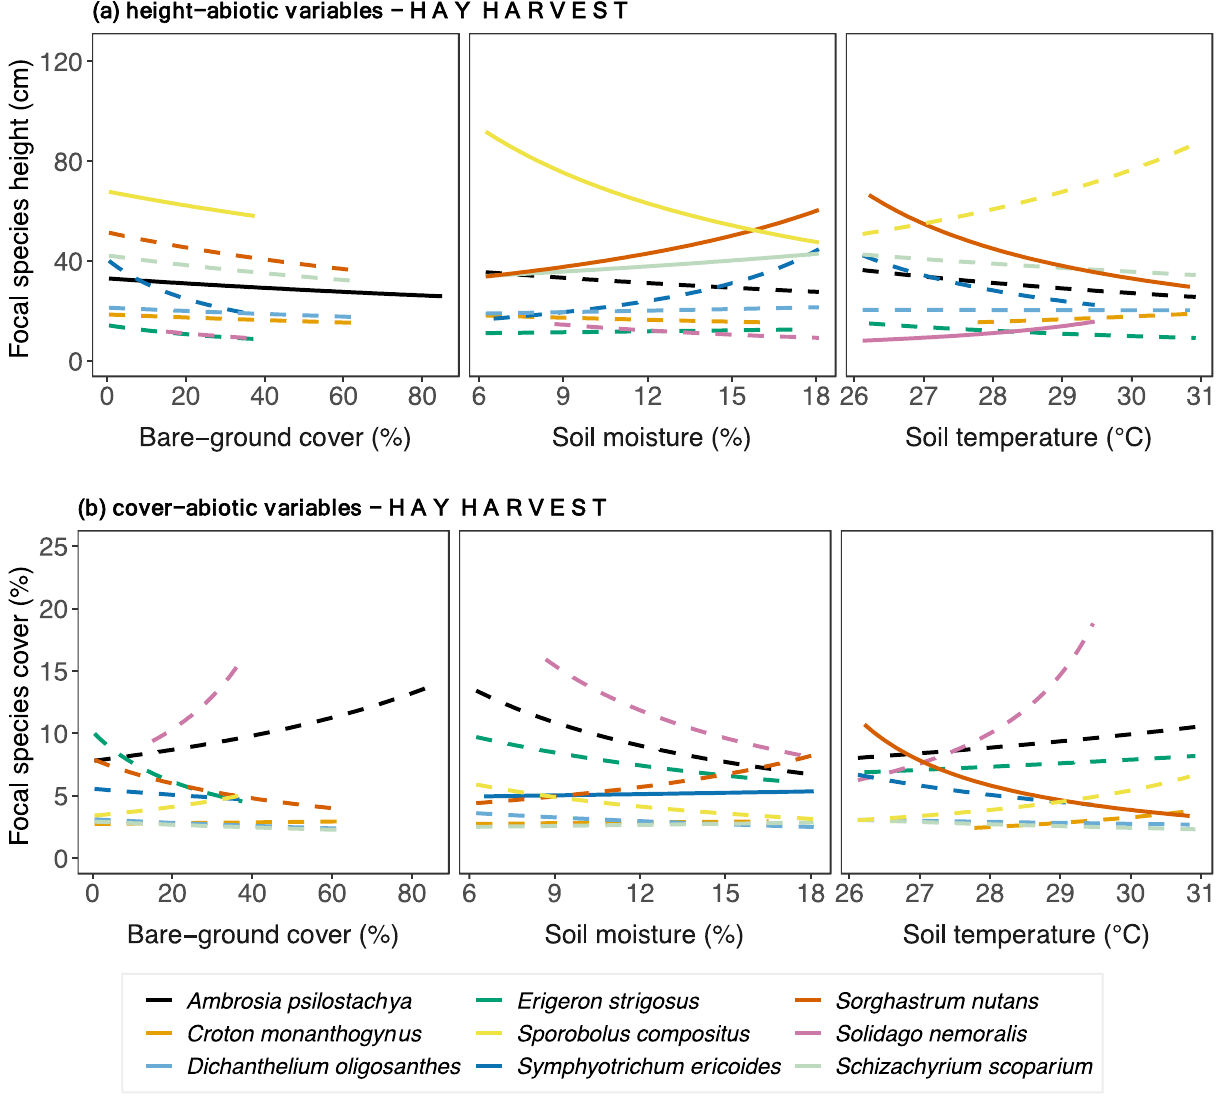
Figure 2. Focal species relationships between ( a ) height, ( b ) cover and abiotic variables in plots with hay harvest across the precipitation gradient. Relationships were estimated by fitting Generalized Linear Mixed Models with log link to both species-specific height and abiotic variables (soil temperature, soil moisture, bare- ground cover). Continuous lines indicate significant relationships, while dashed lines indicate non-significant. P-values are shown in Supplementary Table